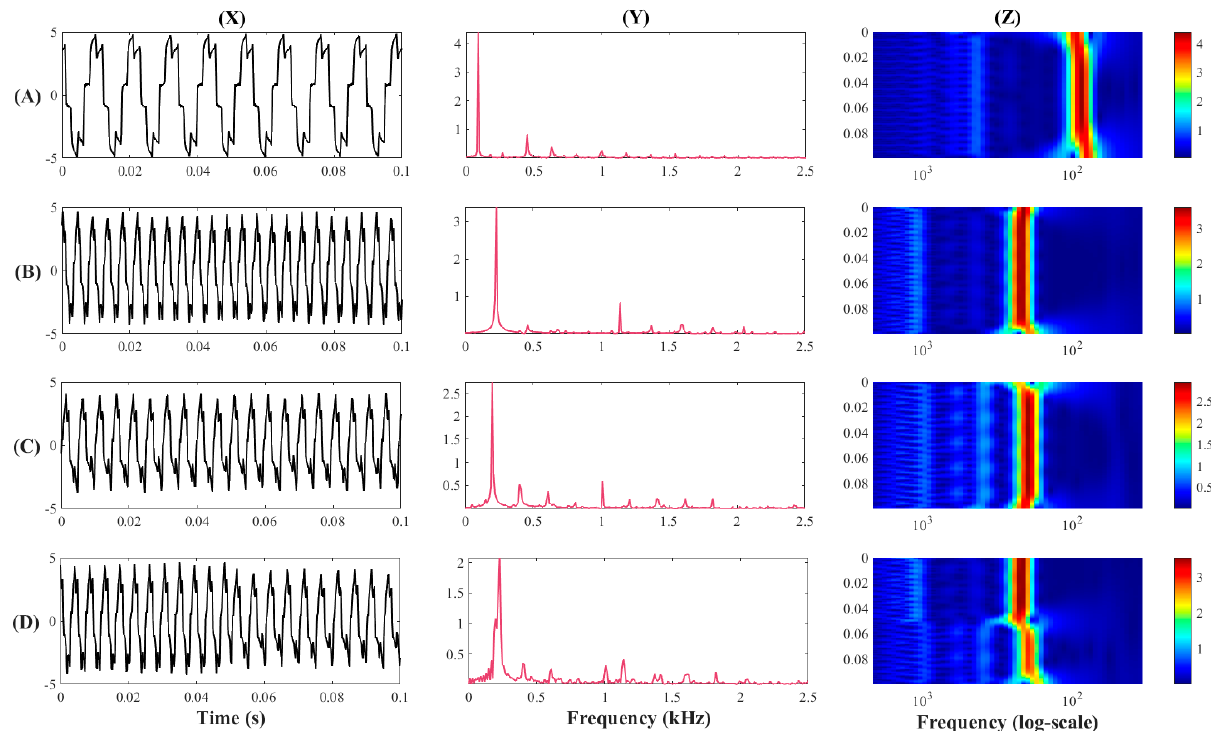
Figure 9. Third harmonic (H3) analysis of the motor currents in healthy state (row A ), ITF fault state (row B ), WSC fault state (row C ), hybrid fault state (row D ). Column X is the sensor acquired time series signal, column Y is the FFT transformation, column Z is the time-frequency representation using CWT. Table 3. NMCSA results.